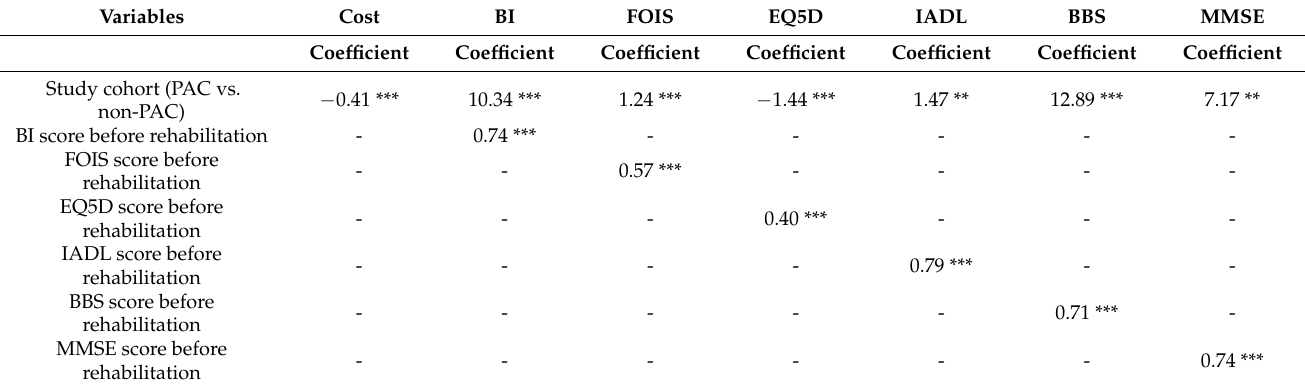
Table 4. The coefficients of significant variables of multiple linear regression model of log of total direct medical cost and total score of each functional status measure after adjusting all effective predictors ( n =